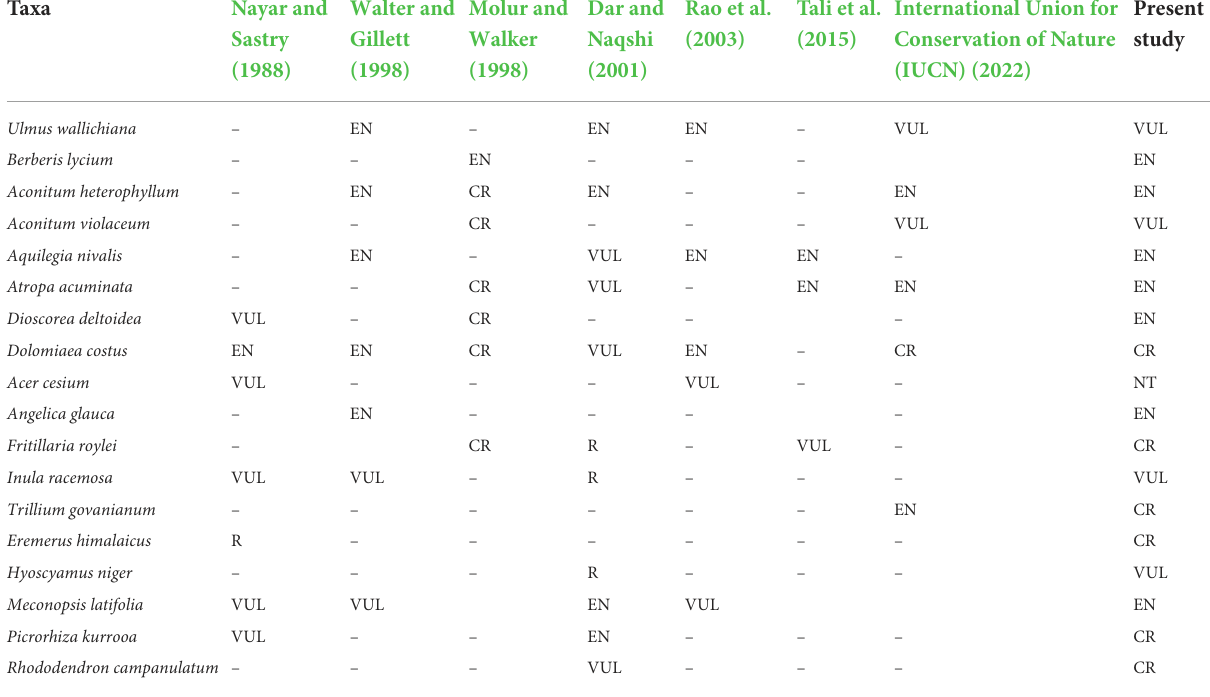
TABLE 5 Threat status of some prioritized plant species as per previous studies. Taxa Nayar and